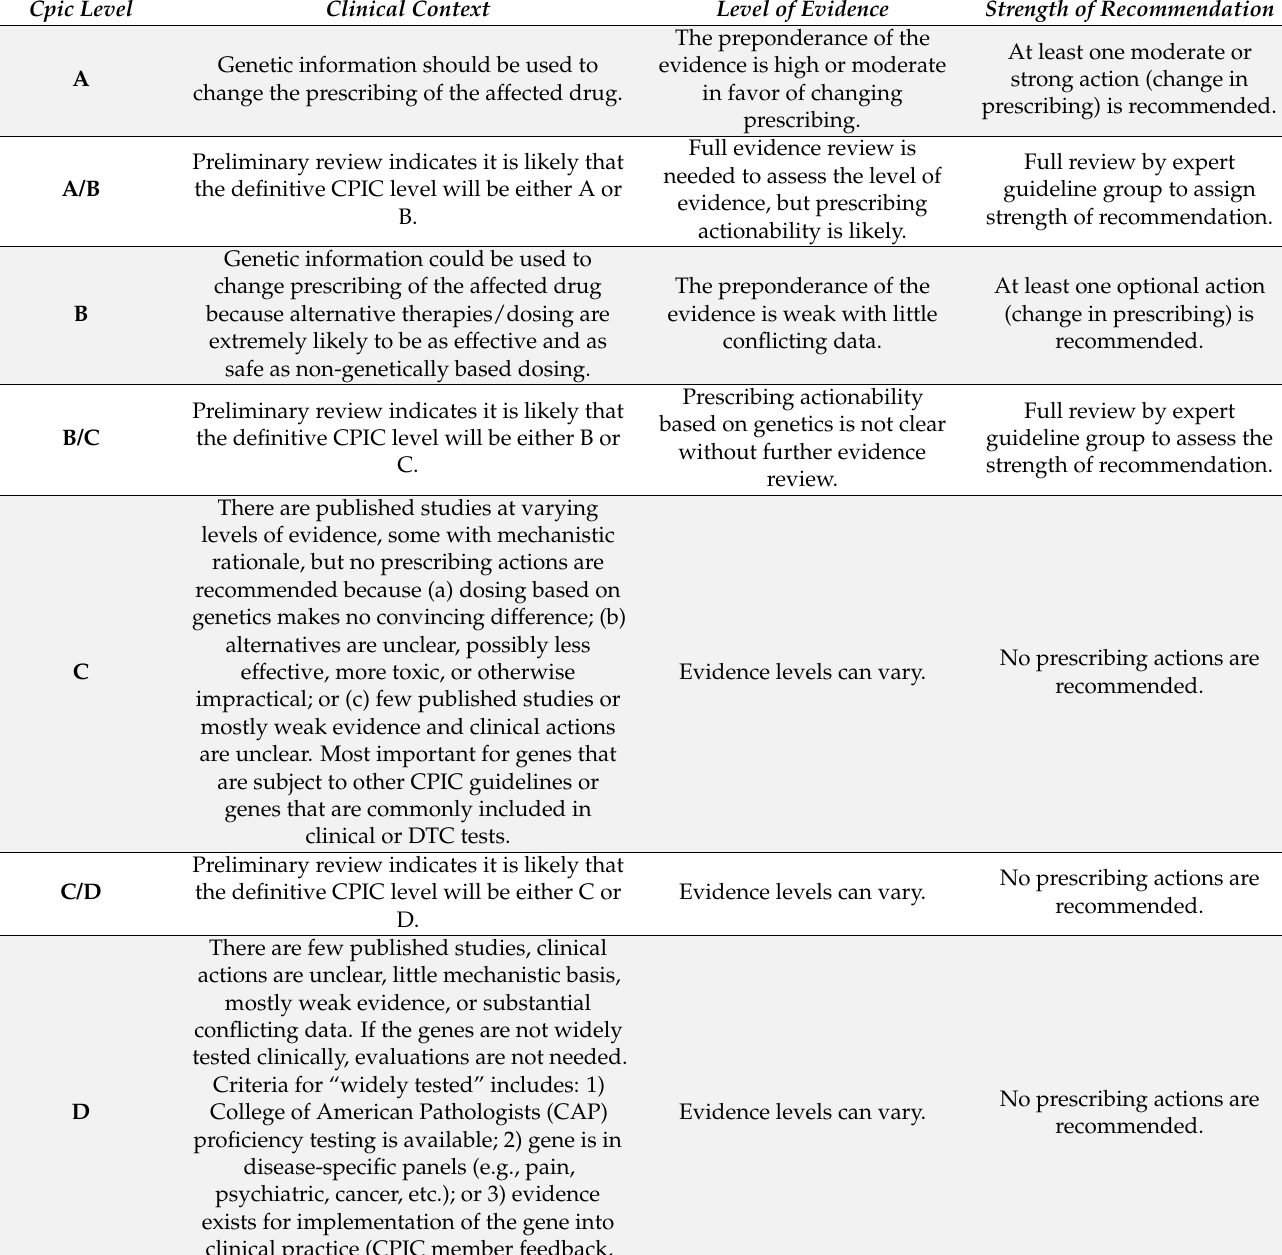
Table 2. Clinical Pharmacogenetics Implementation Consortium (CPIC) new level of clinical relevance for gene/drug